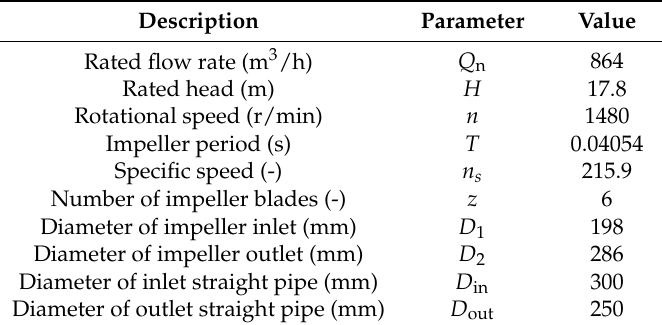
Figure 1. Tested double-suction centrifugal pump. Table 1. Parameters for the pump.